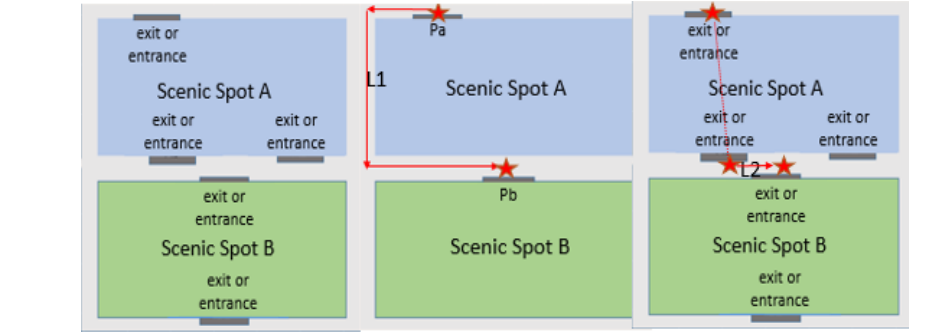
Fig. 1. Sketch Map of Planned Travelling Path for Scenic Spot A and